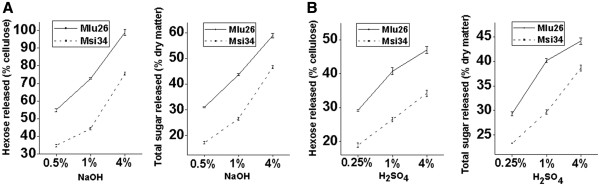
Hemicelluloses positive effect on Biomass digestibility.Miscanthus sample with a relatively higher hemicelluloses level (Mlu26) showing an enhanced biomass digestibility after pretreatments with (A) NaOH or (B) H2SO4 at three concentrations. The biomass digestibility was accounted by either hexoses yield (% cellulose) released from enzymatic hydrolysis after pretreatment or total sugar yield (% dry matter) released from both pretreatment and enzymatic hydrolysis.